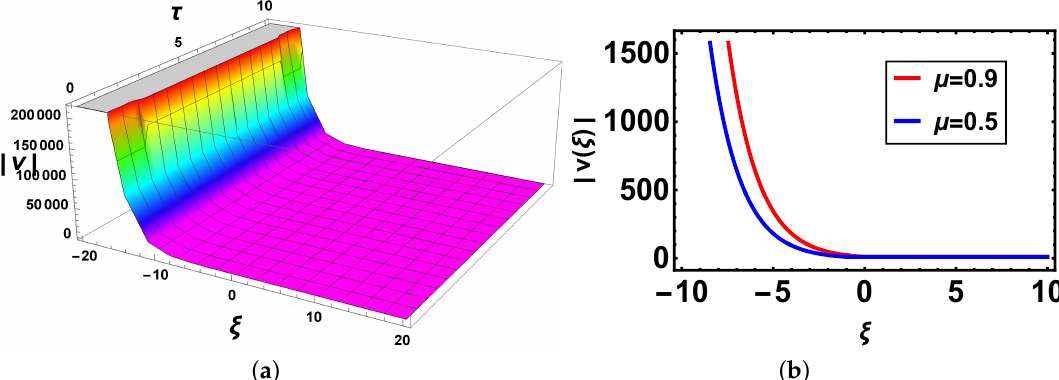
Figure 2. ( a ) 3D and ( b ) 2D plots with the same parameter values as above µ = 0.9 and Θ = 1.1 of v 3 ( ξ , τ ) with the M-truncated